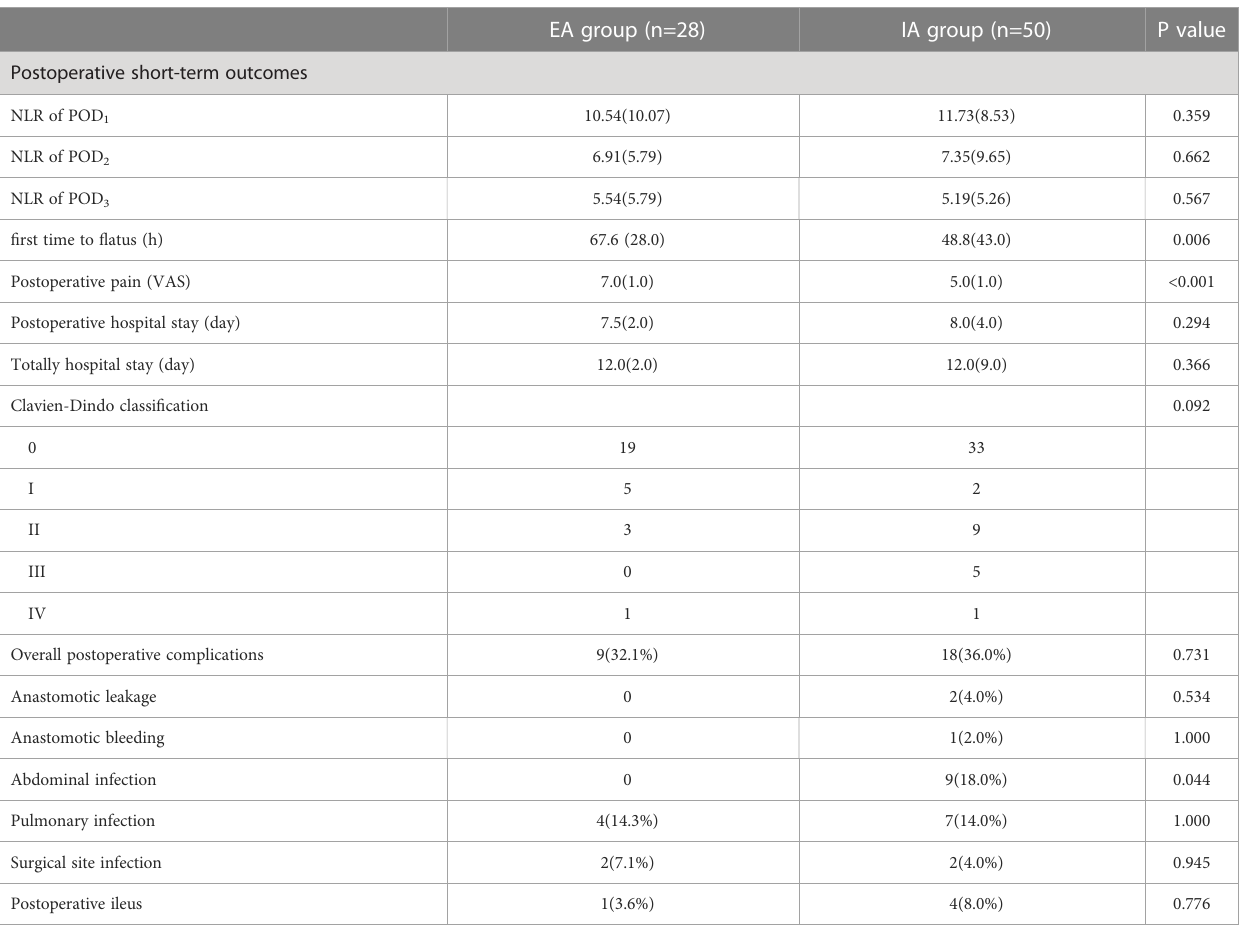
TABLE 3 Postoperative outcomes of two groups.